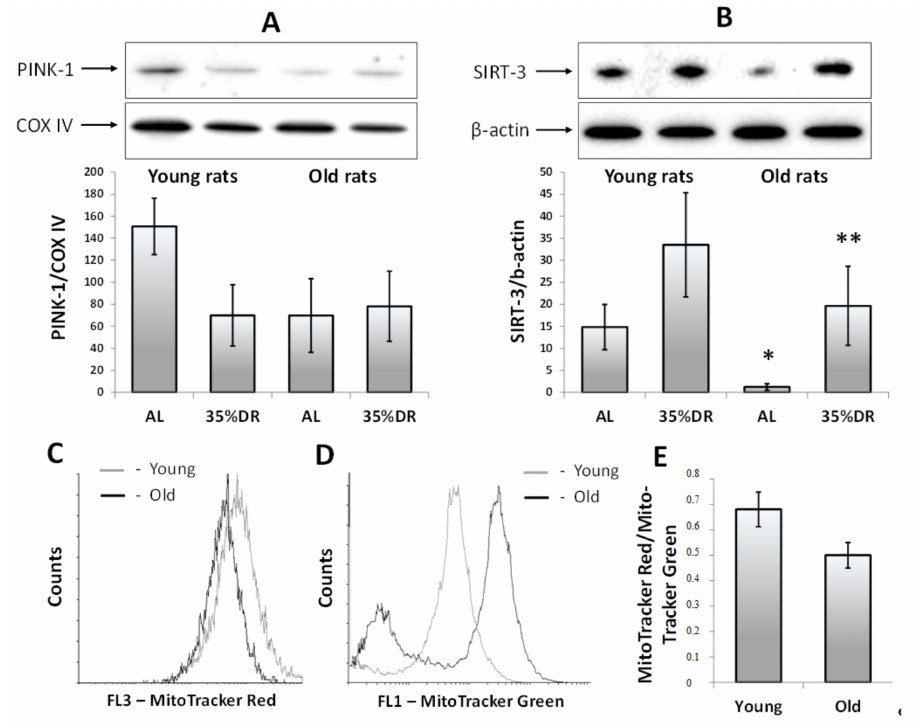
Figure 4. The comparison of the mitophagic activity, the level of SIRT-3, and the mitochondrial membrane potential in the kidneys of young and old rats fed AL or subjected to 35% DR. ( A ) Level of PTEN-induced kinase 1 (PINK-1) in isolated mitochondria from the kidneys of young and old rats; ( B ) Levels of SIRT-3 in kidney homogenates of young and old rats; ( C ) Flow cytometry of primary cultures of RTCs obtained from the kidneys of young and old rats, which were loaded with MitoTracker Red; ( D ) Flow cytometry of non-cultured renal tubular cells (NC-RTCs) obtained from the kidneys of young and old rats and in situ stained with MitoTracker Green; ( E ) Quantification of MitoTracker Red/MitoTracker Green ratio in NC-RTCs from the kidneys of young and old rats. * p < 0.05 compared to the AL group of young rats, ** p < 0.05 compared to the AL group of old